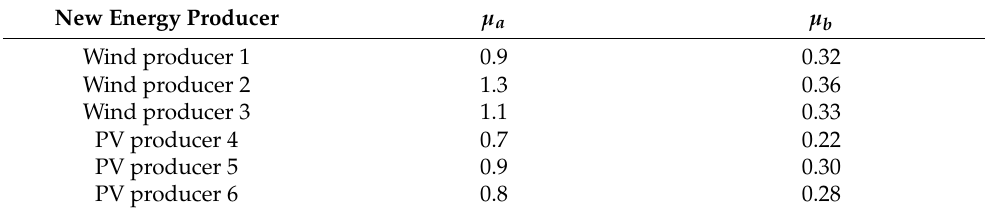
Table A1. Estimated parameters of the mean value of each renewable energy power producer.